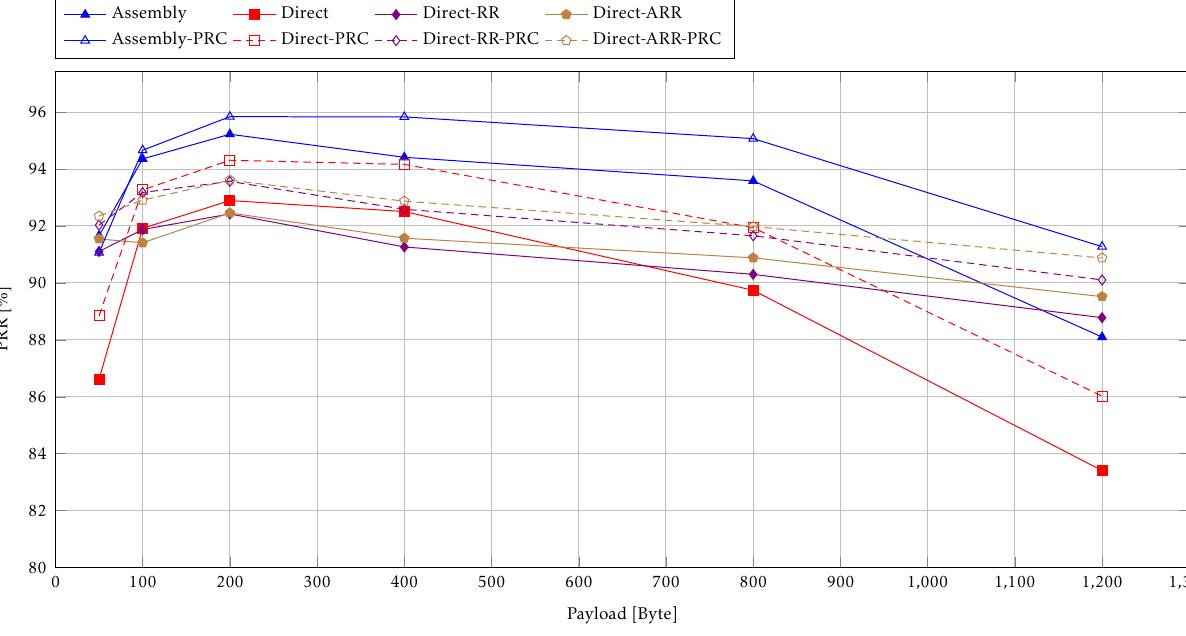
Figure 5. PRR of the Star Network 37 . 5 B/s ; first set of